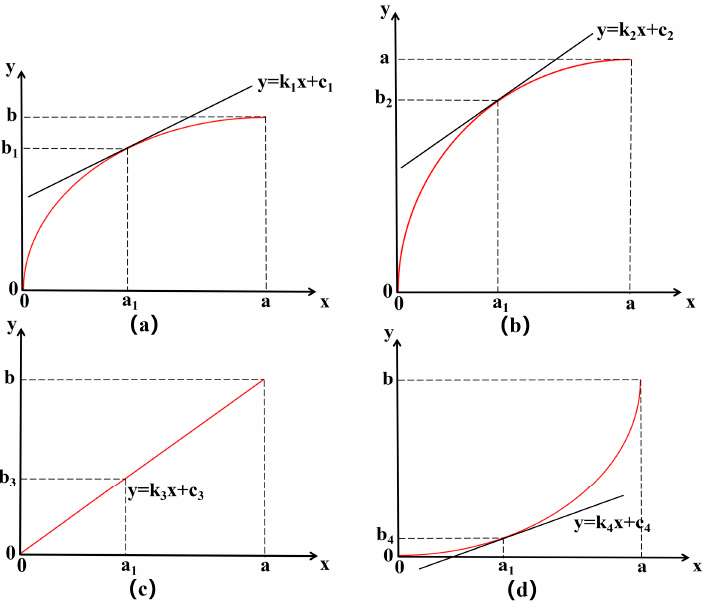
Figure 10. Schematic of cross-sectional profiles of different light coupling structures: ( a ) cone shape, ( b ) circle shape, ( c ) inverted triangle shape, ( d ) concave shape. ( b ) circle shape, ( c ) inverted triangle shape, ( d ) concave